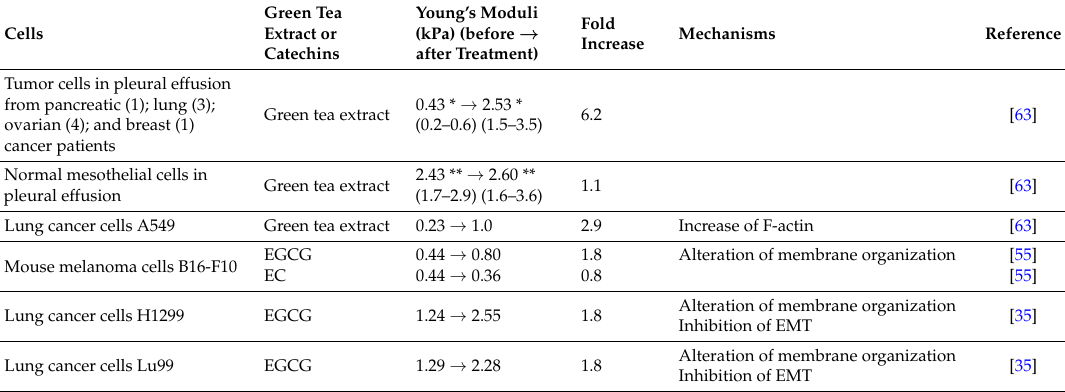
Table 5. Increase of stiffness in cancer cells with green tea extract and EGCG. Young’s Moduli Green Tea Fold Mechanisms Reference (kPa) (before → Cells Extract or Increase after Treatment) Catechins Tumor cells in pleural effusion from pancreatic (1); lung (3); Green tea ovarian (4); and breast (1) cancer patients